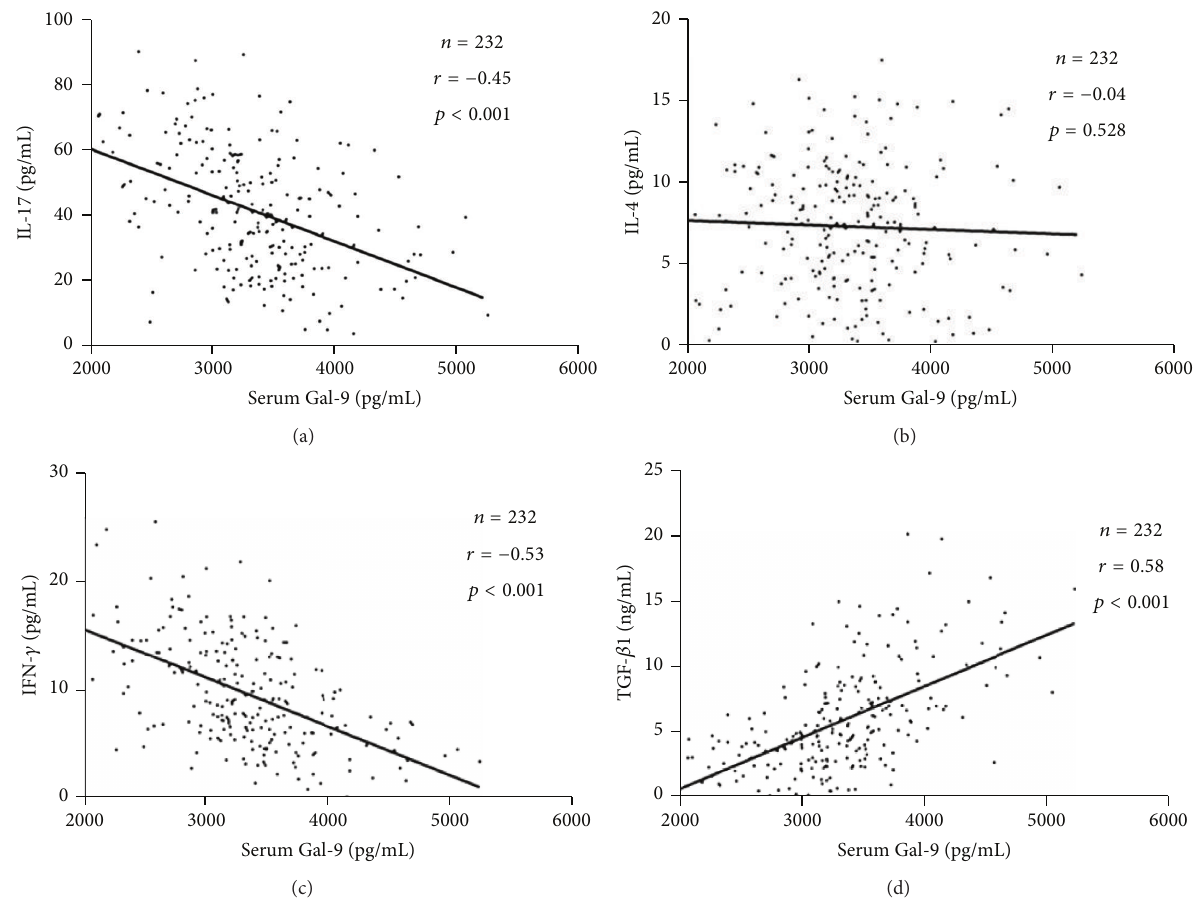
Figure 3: Correlation of Gal-9 levels with cytokines concentrations. (a) Gal-9 levels were shown to be negatively correlated with IL- 17 (Figure 3(a)) and IFN- 𝛾 (Figure 3(c)) but positively associated with TGF- 𝛽 1 (Figure 3(d)). (b) Gal-9 levels do not correlate with IL-4 concentrations (Figure 3(b)).